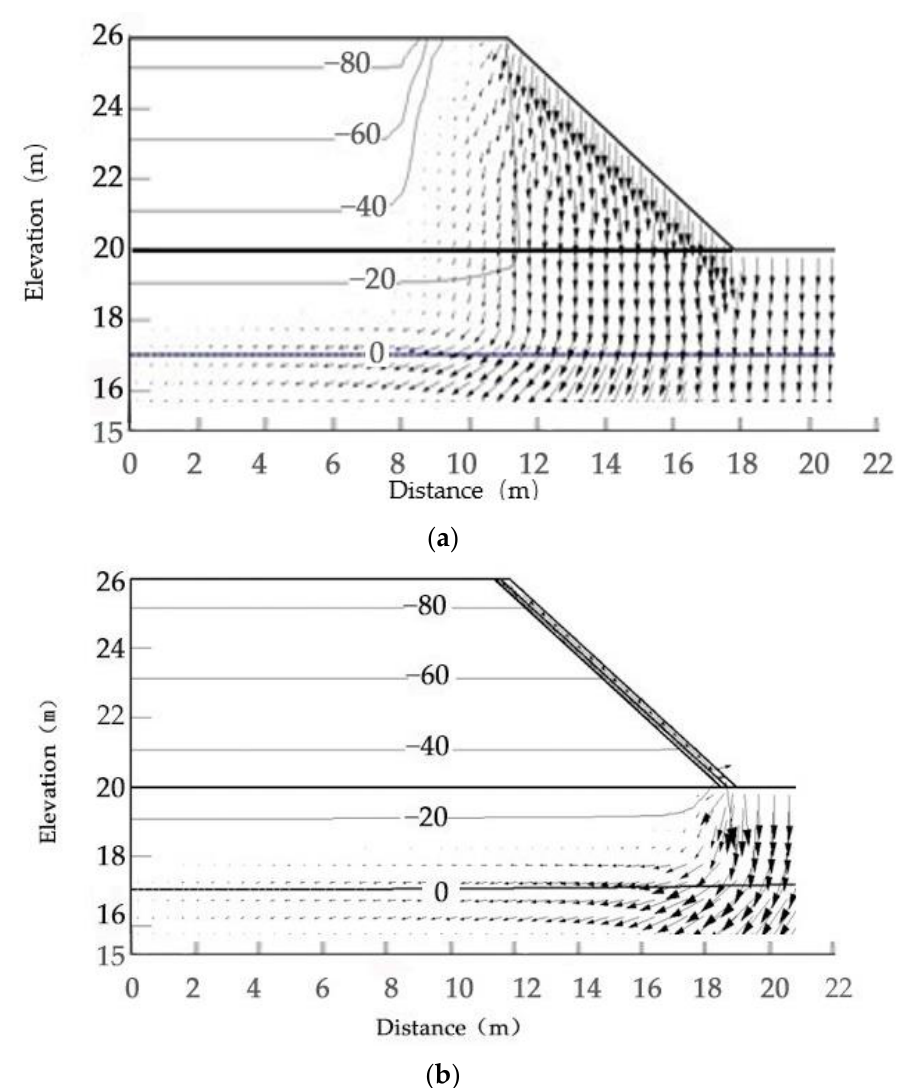
Figure 5. Pore-water pressure distribution in ( a ) traditional subgrade; ( b ) the subgrade with a capillary barrier at the end of the year.